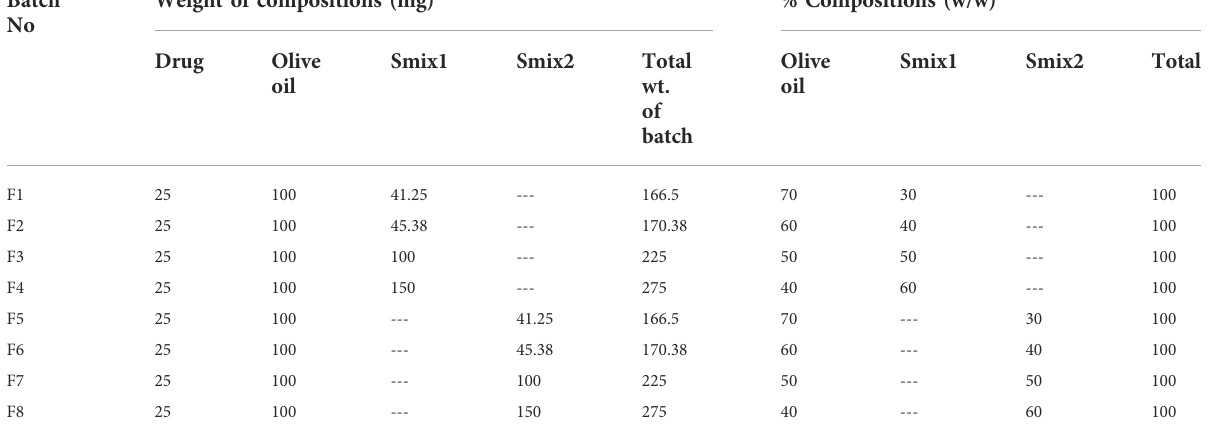
TABLE 1 Composition of different formulations. Batch Weight of compositions No